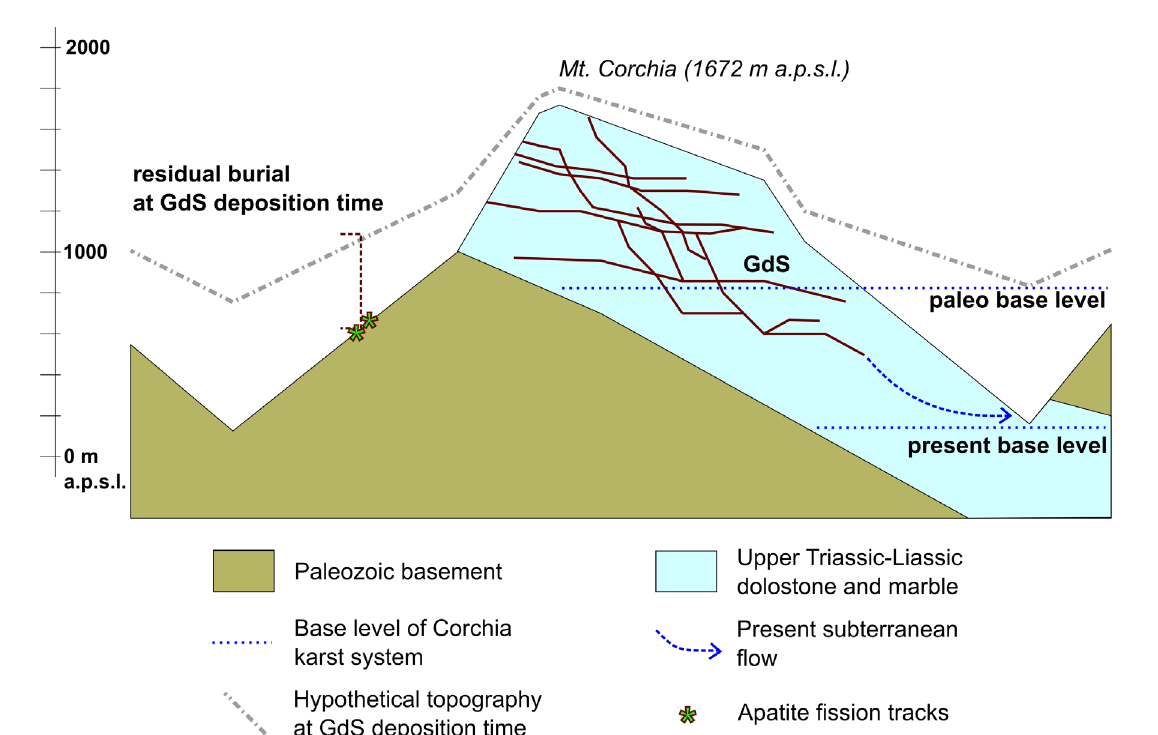
Figure 6. Schematic representation of the geomorphic evolution of Mt. Corchia in the last 1.2–1.6 Ma, considering the hypothesis that valleys were affected by an erosion rate higher than carbonate ridges.